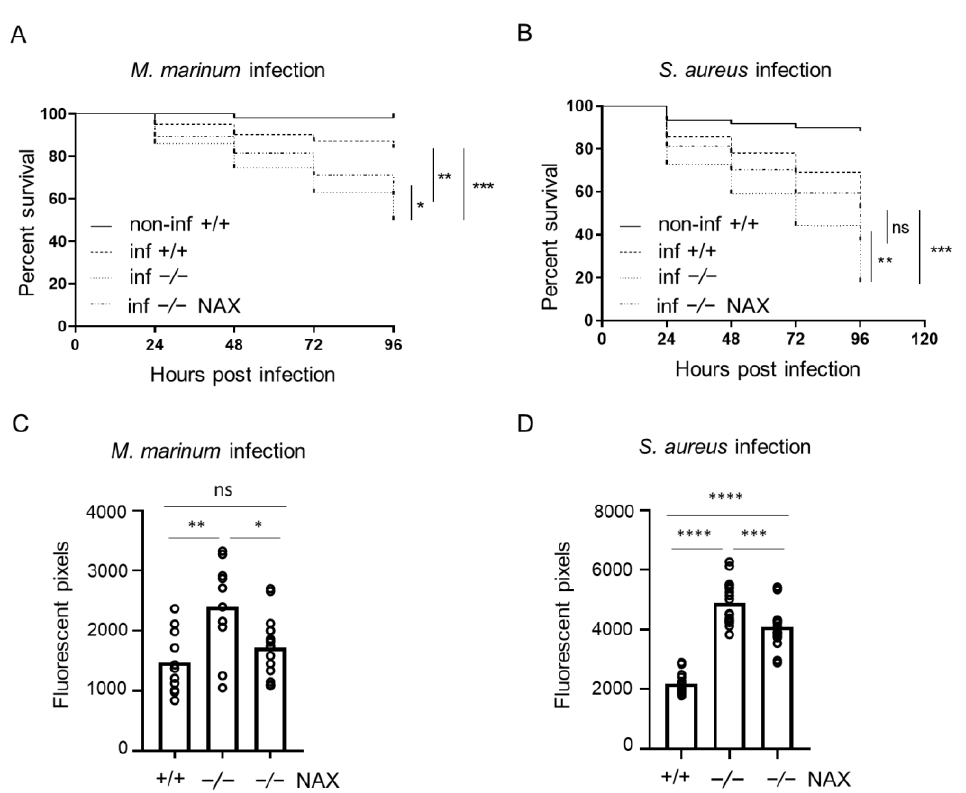
Figure 2. Galanin deficiency results in higher mortality and bacterial burden after vein infection. ( A , B ) Survival rate in mock injected larvae (non-inf +/+), infected wild-types (inf +/+), infected gal − / − mutants (inf -/-) and infected gal − / − mutants treated with NAX 5055 (inf -/- NAX) after ( A ) M. marinum or ( B ) S. aureus vein infection. ( C , D ) Bacterial burden in infected wild-type larvae, infected gal − / − mutants and infected gal − / − mutants treated with NAX 5055 after ( C ) M. marinum or ( D ) S. aureus vein infection. Data are combined from three biological replicates (n = 10 larvae/group). * p < 0.05; ** p < 0.01; *** p < 0.001; **** p < 0.0001; ns, non-significant.